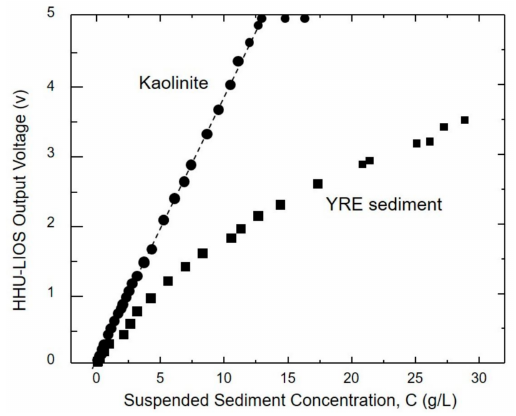
Figure 6. HHU-LIOS responses to the changes of SSC for YRE sediment and kaolinite. (A dashed line is added to show the linear responses on kaolinite